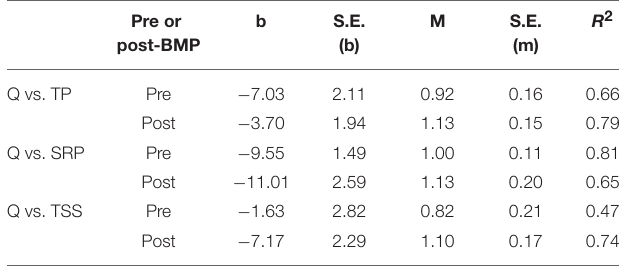
TABLE 3 | Coefficients of regression lines in Figure 8 (log-transformed